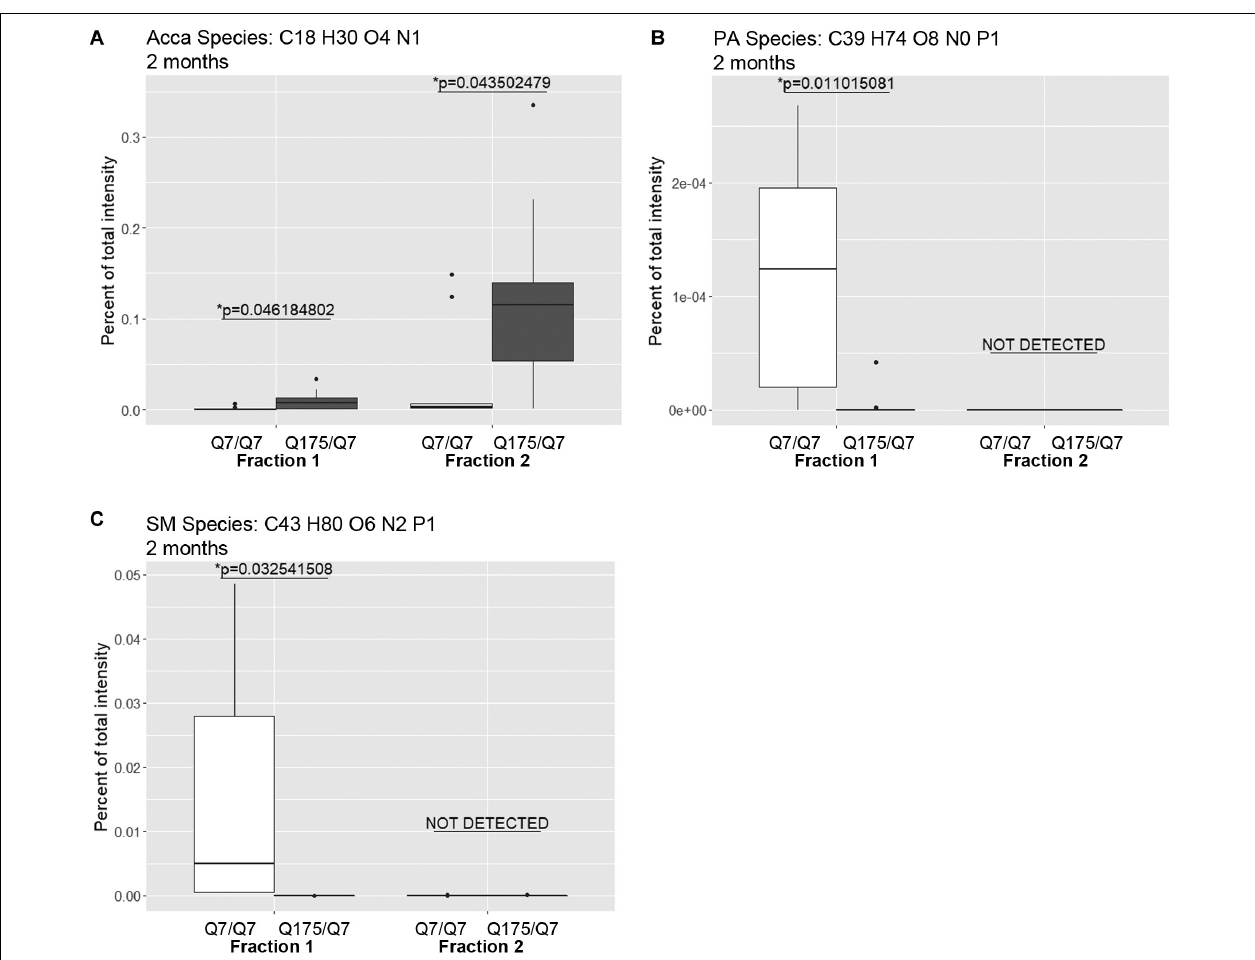
FIGURE 5 | Levels of selected individual species of lipids detected by LC-MS/MS in fractions 1 and 2 of continuous density gradients of fractionated 2 months old Q175/Q7 and Q7/Q7 striata. Graphs show Tukey-style box plots where the lower and upper hinges correspond to the first and third quartiles (the 25th and 75th percentiles) as described in section “Materials and Methods.” Data beyond the end of the whiskers are called “outlying” points and are plotted individually. Outliers were not removed from statistical analysis. Changes at 2 months are shown for specific species of (A) Acyl Carnitine (Acca), (B) Phosphatidic acid (PA), and (C) Sphingomyelin (SM). Cholesteryl ester species was not detected by LC-MS/MS in the 2-month samples. All significant changes are shown in Supplementary Tables 1–8 . Comparisons were made between genotype for each fraction ( ∗ p < 0.05, unpaired t -test, N = 9 per